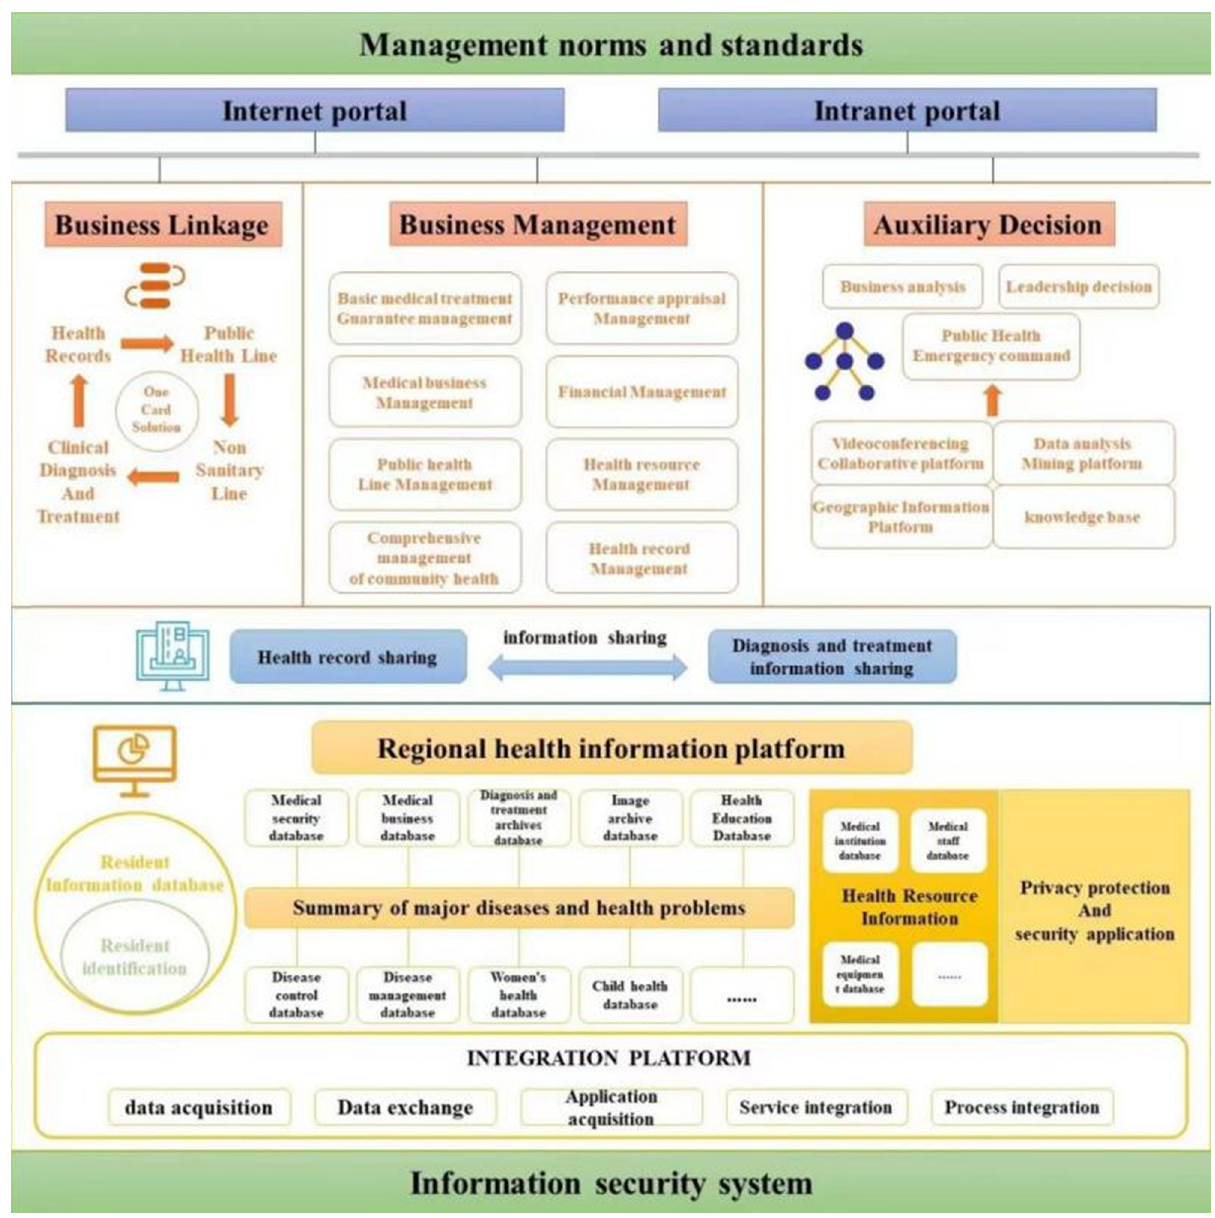
Figure 1: Recursive equations in network